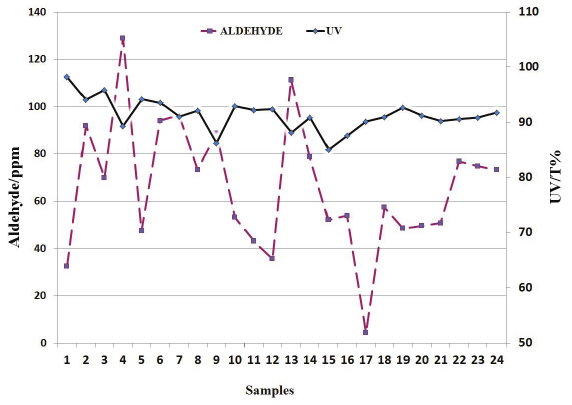
Figure 3: Aldehyde decreased with increasing the amount of water cycle entering to anionic reactor.